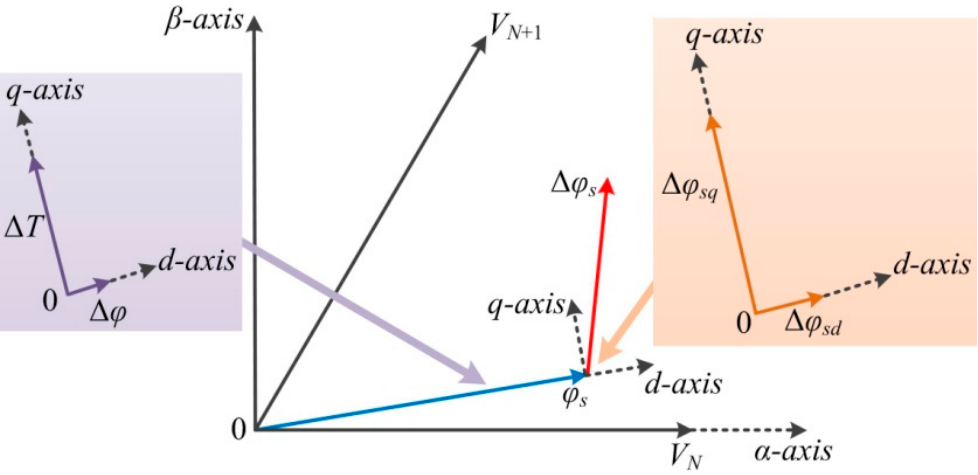
Figure 8. Analysis of error compensational effects in transient-state.